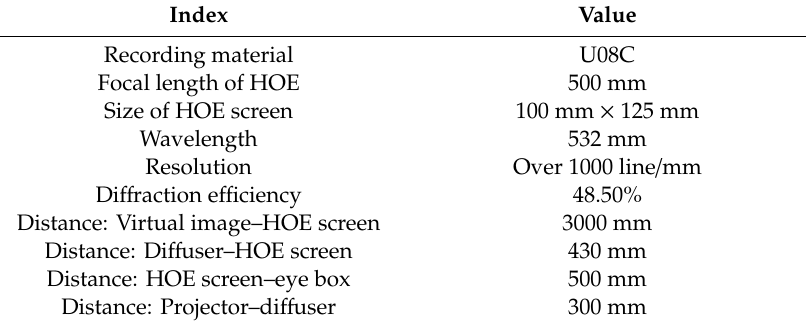
Table 1. Specifications of a floating hologram projection system using